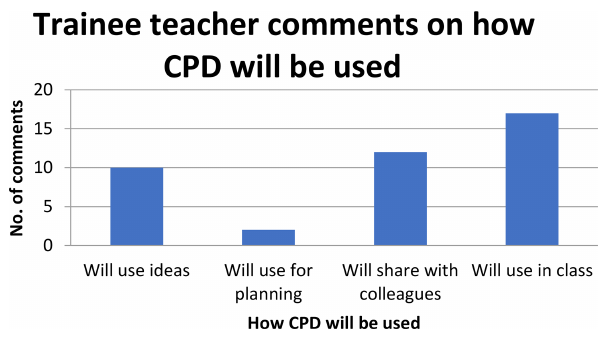
Figure 5. Comments on how the CPD will be